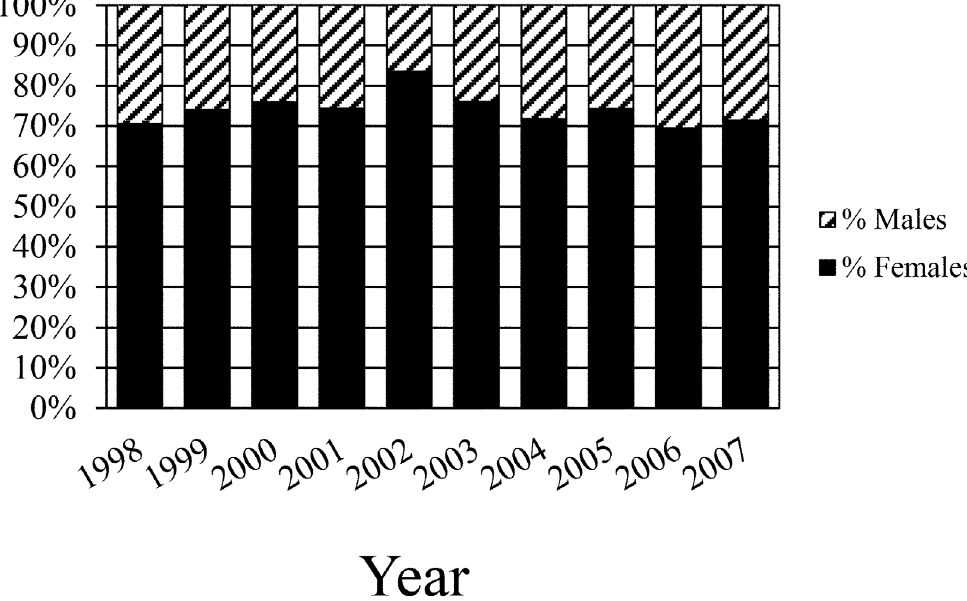
Fig 3. Estimated annual percentage male and female juvenile loggerhead ( Caretta caretta ) sea turtles captured in Core and Pamlico Sounds, North Carolina, USA, June to August, 1998 –